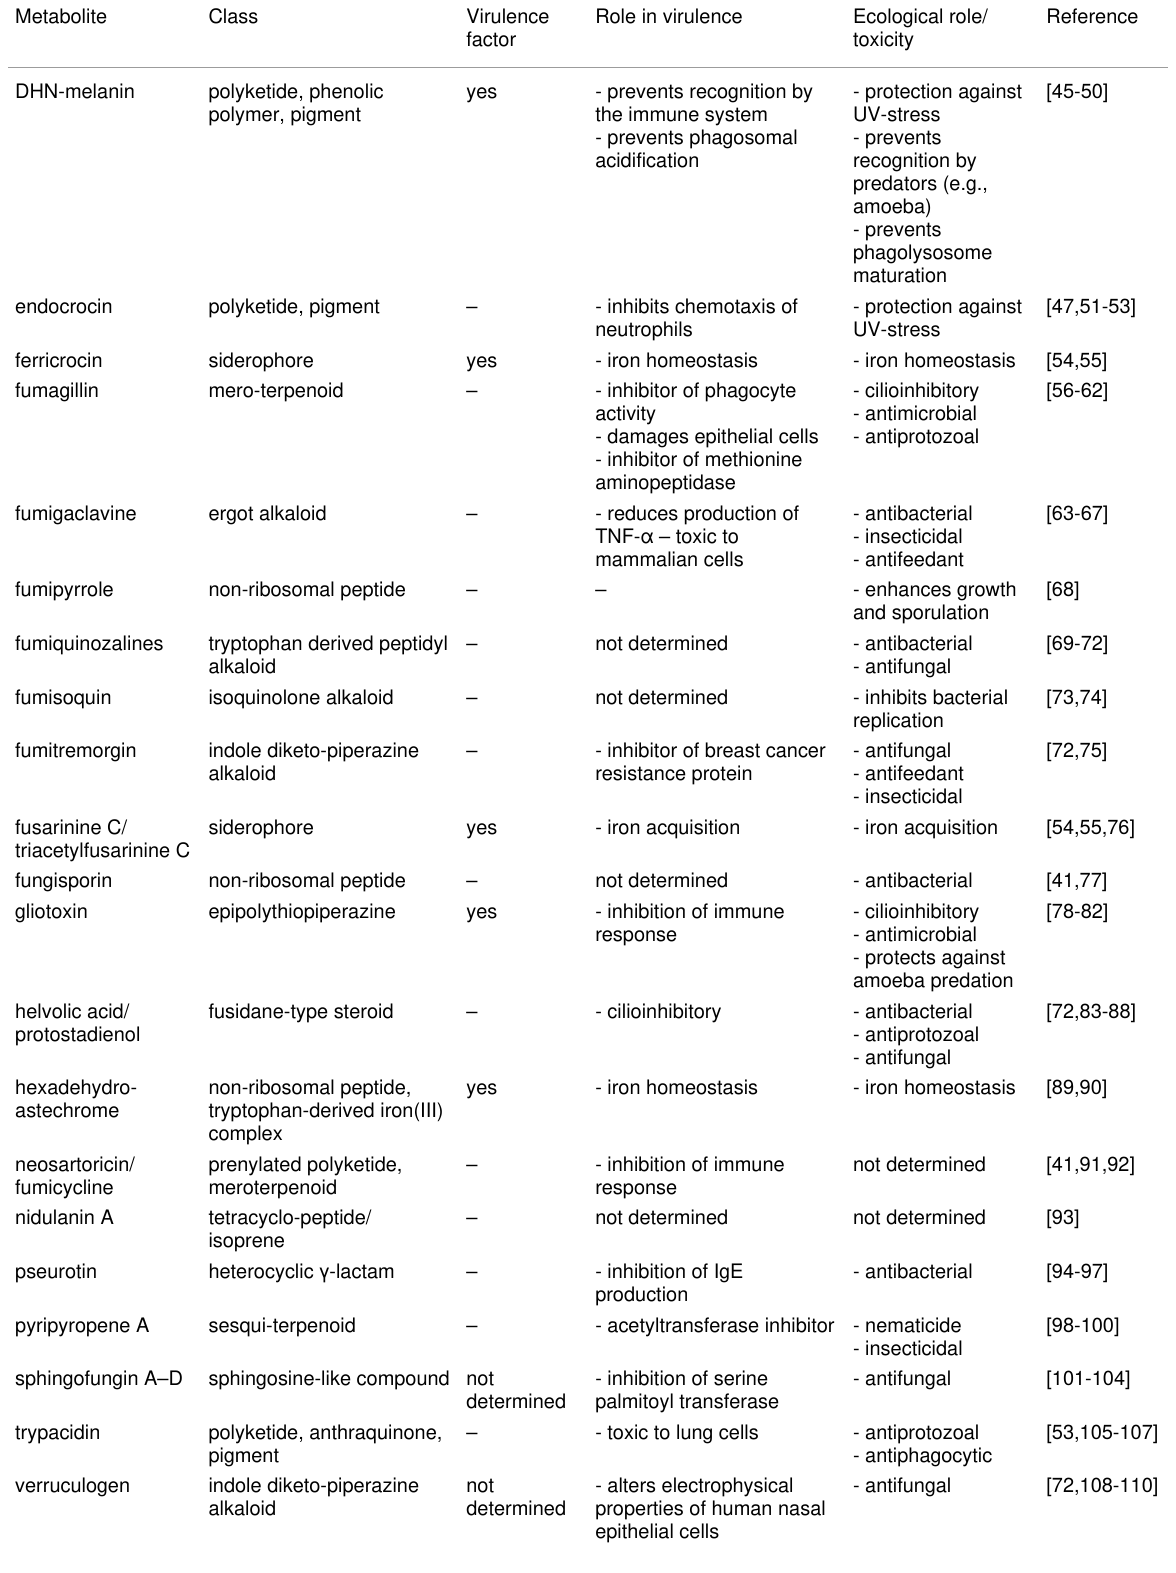
Table 1: Overview of Aspergillus fumigatus secondary metabolites and their roles during virulence and in their ecological context.